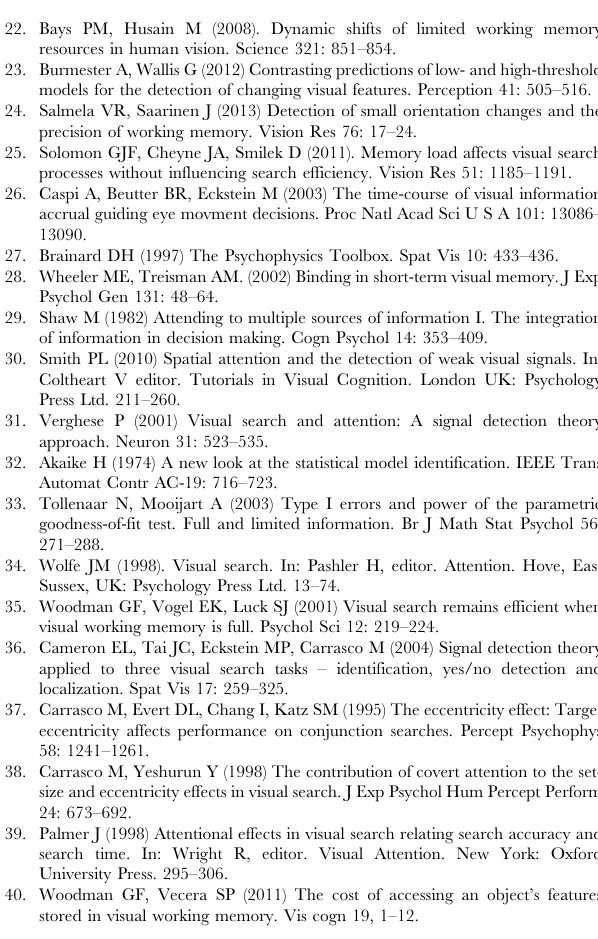
Figure S1 Individual P values for a X 2 goodness-of-fit test for the 1-Template, 2-Template and 2-Noisy-Tem- plate models of single- and dual-target search.